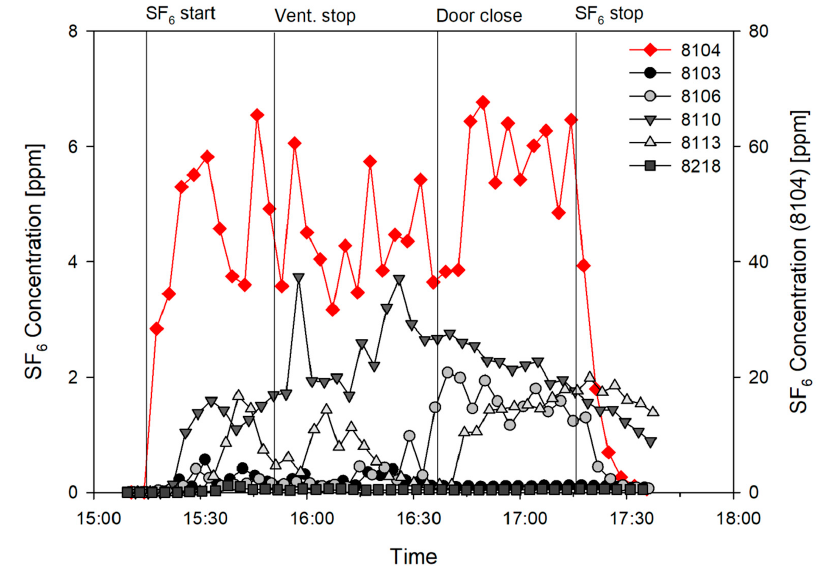
Figure 3. Tracer gas experimental results.